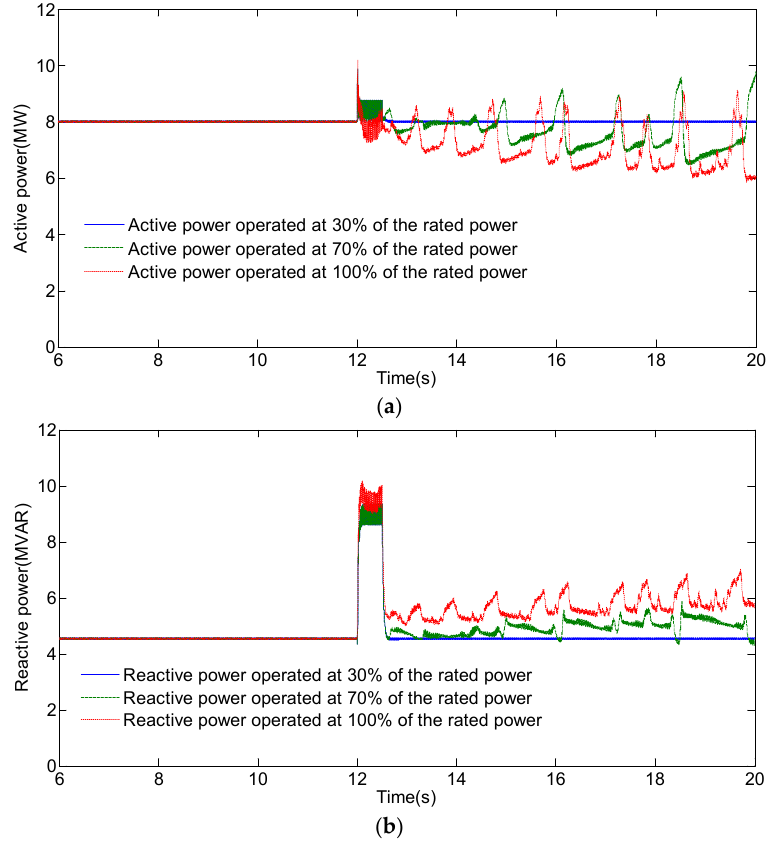
Figure 9. ( a ) The active power of the system when the DFIG operates at different levels of rated power; ( b ) The reactive power of the system when the DFIG operates at different levels of rated power.